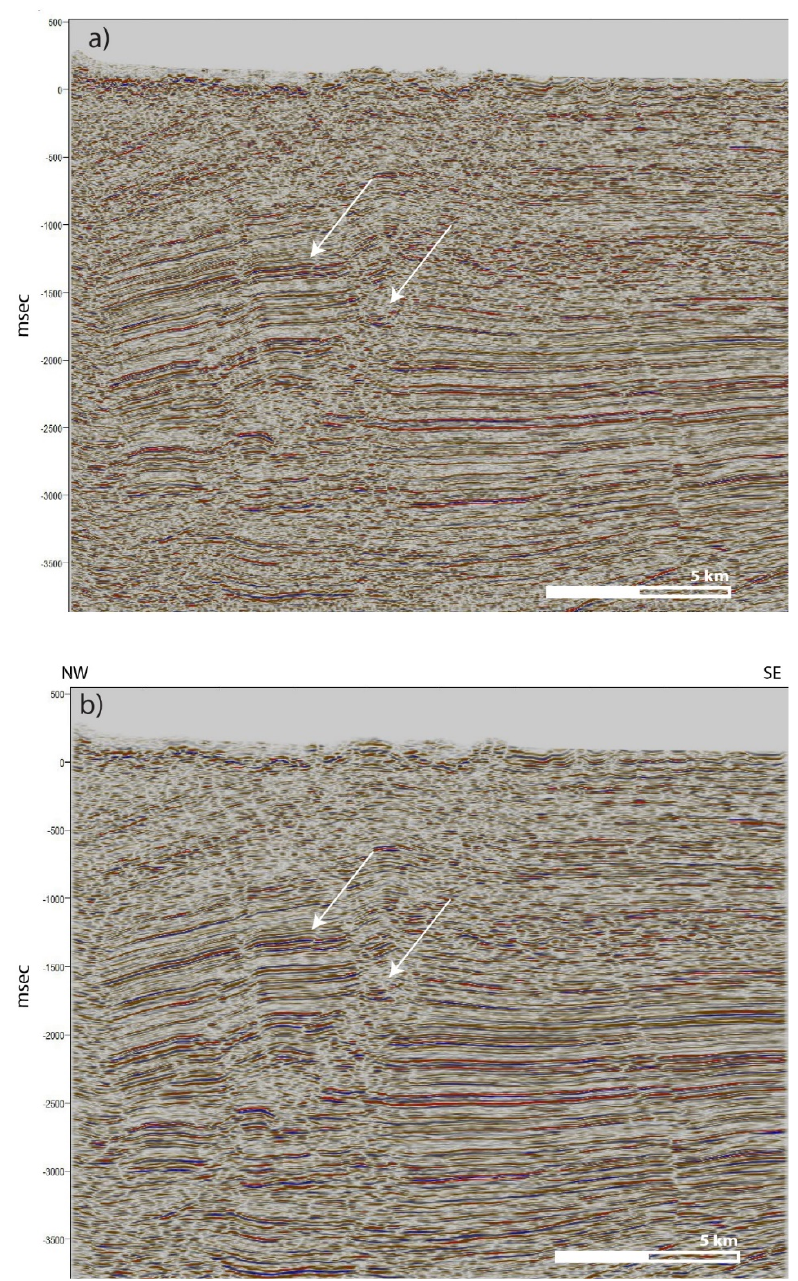
Figure 5. ( a ) Amplitude seismic cross-section before applying the structure smoothing filter, and ( b ) after applying the structure smoothing filter. The white arrows indicate areas of increased reflector resolution and reduced noise near the Cusiana fault plane after filtering in Figure 5b. For the profile location, see Figure 1.